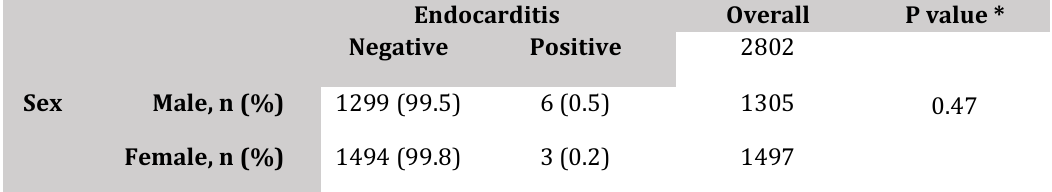
Table 2 . Comparison sex in patients with and without BE.